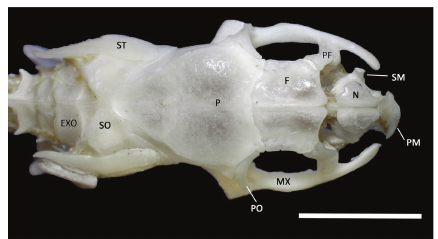
Figure 1: Dorsolateral view of the head of Sordellina punctata (IBSP 66199). Bar = 5mm. fr: frontal; ina: internasal; lo: loreal; na: nasal; pa: parietal; po: postorbital; pf: prefrontal; pre: preocular; ro: rostral; sl: supralabials; so: supraocular.